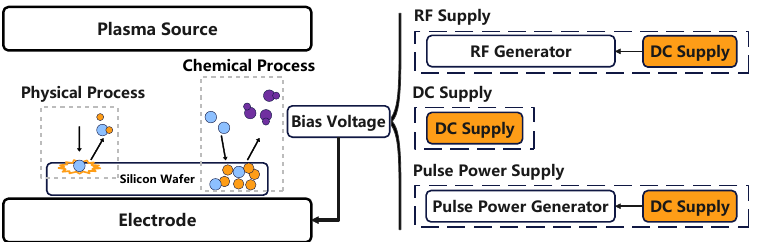
Figure 1. Etching process and bias